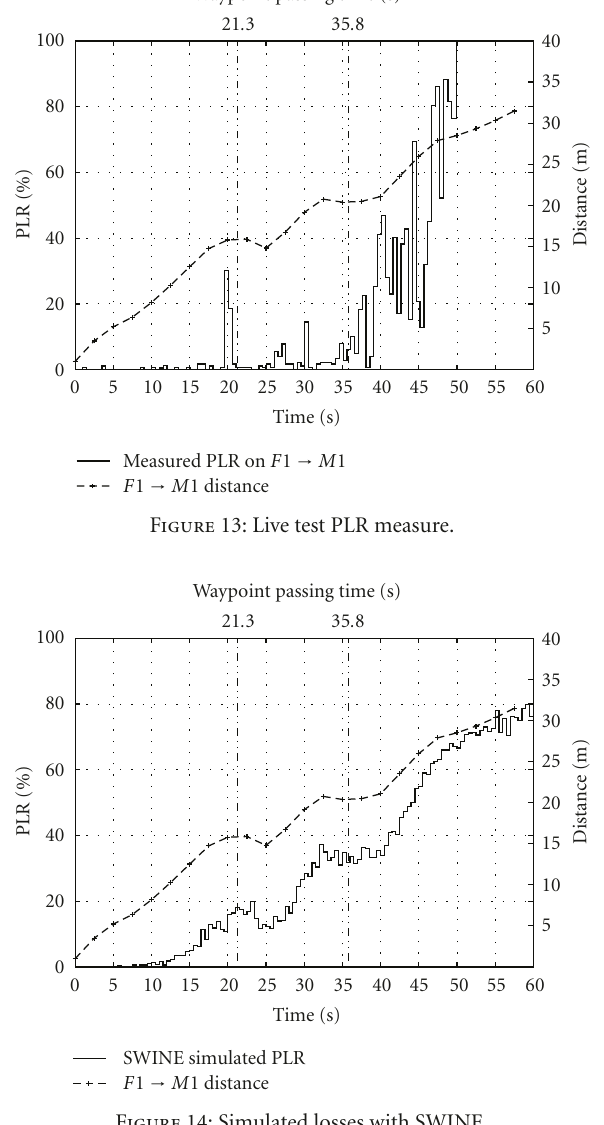
Figure 14: Simulated losses with SWINE.